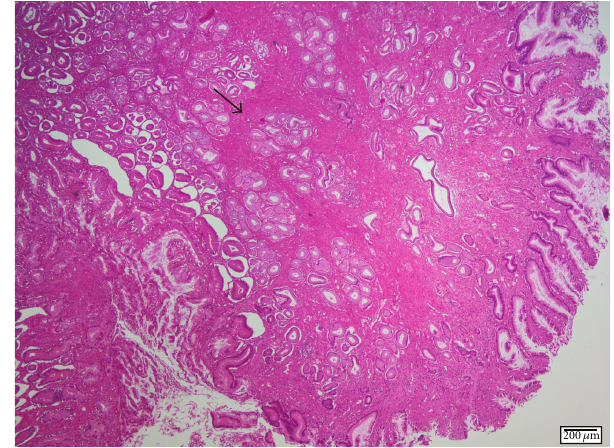
Figure 1: Photograph of the opened stomach showing two intra- luminal and closely related polyp-like masses, measuring approxi- mately 15 mm in diameter that was easily seen in the pyloric region (arrows).Theinsetillustratesthemorphologicalaspectsofthecross- sectionofthepolypoidmasswithawhitetograyanddensestructure and muscular layer thickening (arrow).